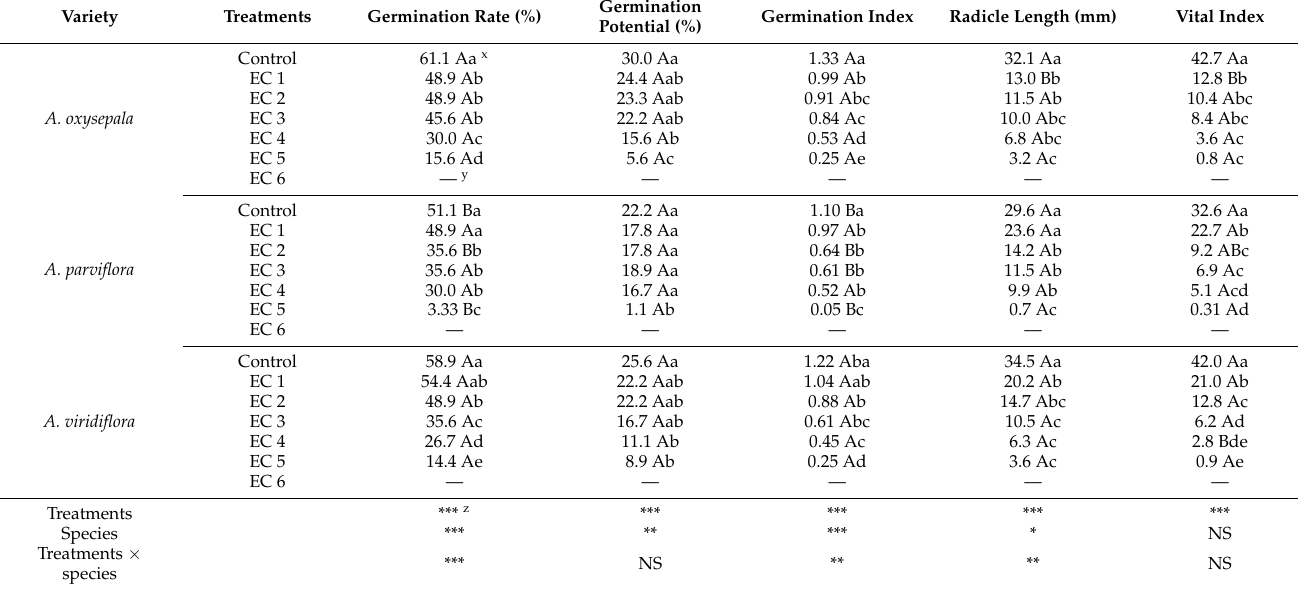
bars represent standard error (SE). Table 3. Germination rate, germination potential, germination index, radicle length, and vital index of A. oxysepala , A. parviflora , and A. viridiflora under the treatments of distilled water (control) and salt solution at electrical conductivity (EC) of 1 dS · m − 1 (EC 1), 2 dS · m − 1 (EC 2), 3 dS · m − 1 (EC